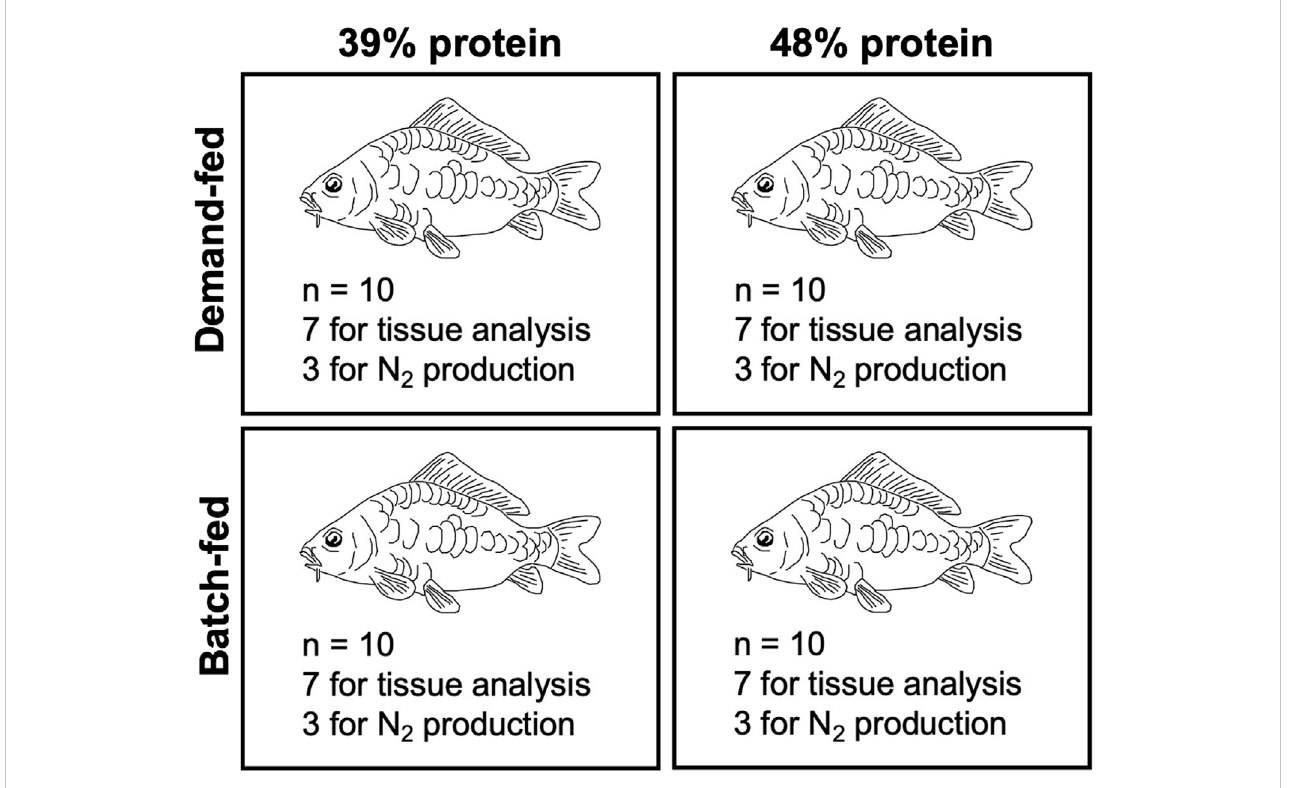
FIGURE 1 Experimental treatments in the carp feeding experiment and endpoint measurements. Schematic depiction of experimental groups of carp and treatments. Numbers of fi sh used for N 2 measurements and tissue analysis are also provided. The feed experiment was performed in triplicate ( N = 3).